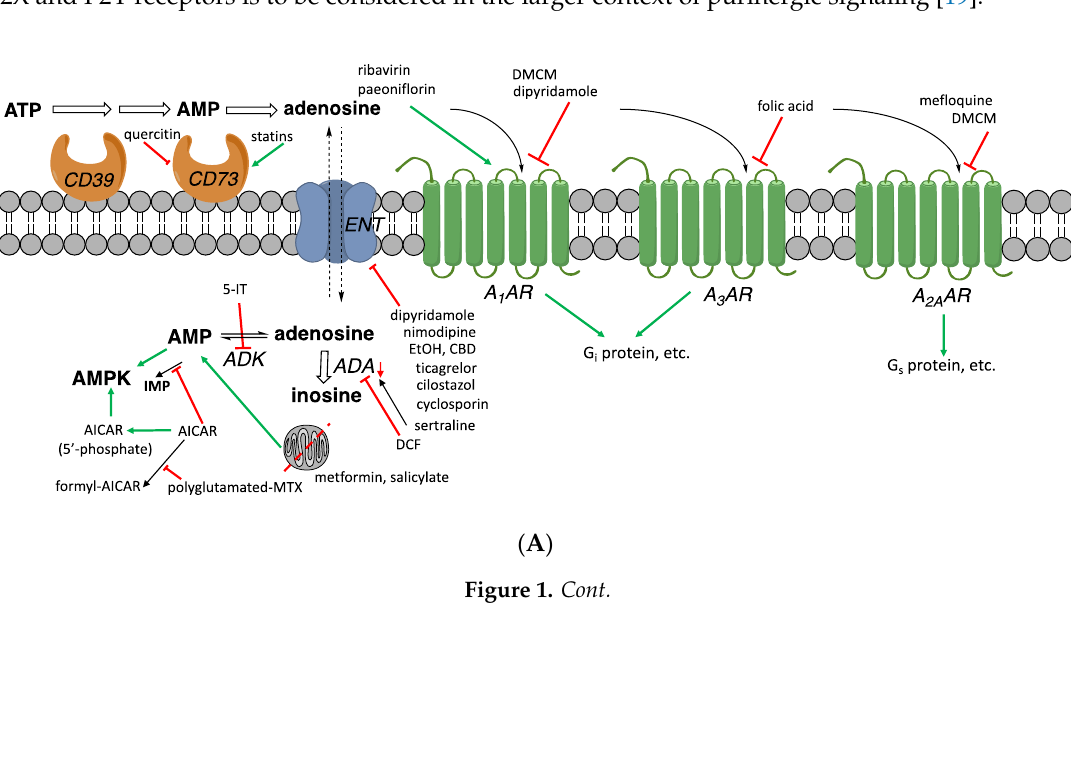
Figure 1. ( A ) Adenosinergic pathways and their putative modulators among non-AR drugs. These interactions have been found in model systems in vitro or in vivo and do not necessarily imply that a compound achieves the indicated effect when administered in humans. Intracellular processes resulting in elevated adenosine concentrations are shown. The A 2B AR (not shown) activates G s protein and has a low affinity for adenosine. ( B ) Drugs or treatments that influence adenosinergic signaling, including those having an undetermined or unclear mechanism (all are stimulatory, except diazepam). Inhibitory and stimulatory effects on the production of cAMP, mediated by Gi and Gs proteins, are shown. Intracellular adenosine concentrations can also be raised through inhibition of ADK (e.g., by 5-iodotubercidin (5-IT, structure not shown), ABT-702 18 , or A-134974 19 ) or of adenosine deaminases (e.g., by deoxycoformycin, DCF 20 ). Moreover, AICAR inhibits an enzyme that metabolizes AMP by deamination, to indirectly increase intracellular adenosine. Compounds that are reported to influence adenosine signaling, but through undetermined AR subtypes, are not listed here. Plasma adenosine is locally cleared in a few seconds [20]. In humans, pharmacologic doses of intravenous adenosine have a plasma half-life of only ~1 min [21]. These properties mean that plasma adenosine levels (100–1000 nM) [20], while important, are not the only relevant concentration. Adenosine is a local or paracrine modulator, so local levels dictate most of the physiologic effects. This means that adenosine has a plethora of actions, which depend on the particular cells and specific tissue involved. 1.2. Action of Various Drugs Involves Adenosine While the strength of the data varies, adenosine is proposed to be involved in the effects of ethanol, anti-inflammatory drugs, vasodilators, and various drugs and natural products used for treating depression, anxiety, behavioral and sleep disorders, and pain. Possible actions include